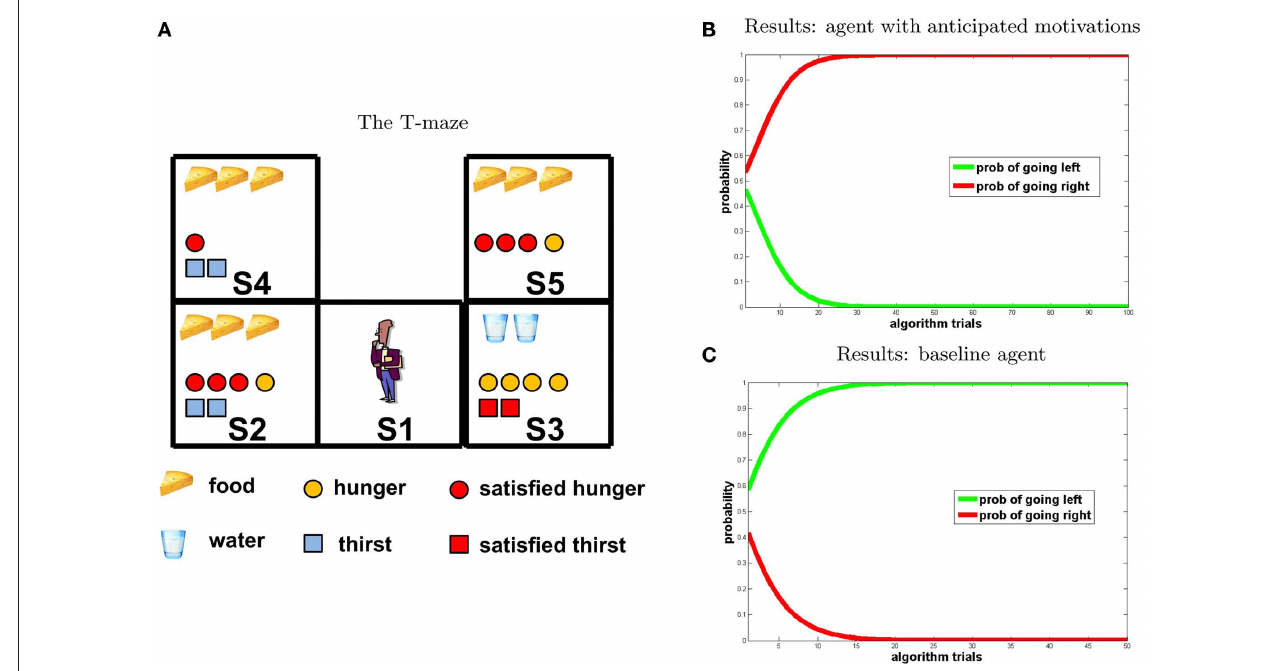
values that are satiated by consumption of potential rewards in the corresponding position of the maze. Graphically, optimal behavior corresponds with choosing the path with the largest number of red forms. (B,C) Results of the first experiment (B) agent with anticipated motivations; (C) baseline model. The graph represents the probability assigned to the policy associated to “going right” (red) and “going left” (green), respectively, at each iteration of the reward